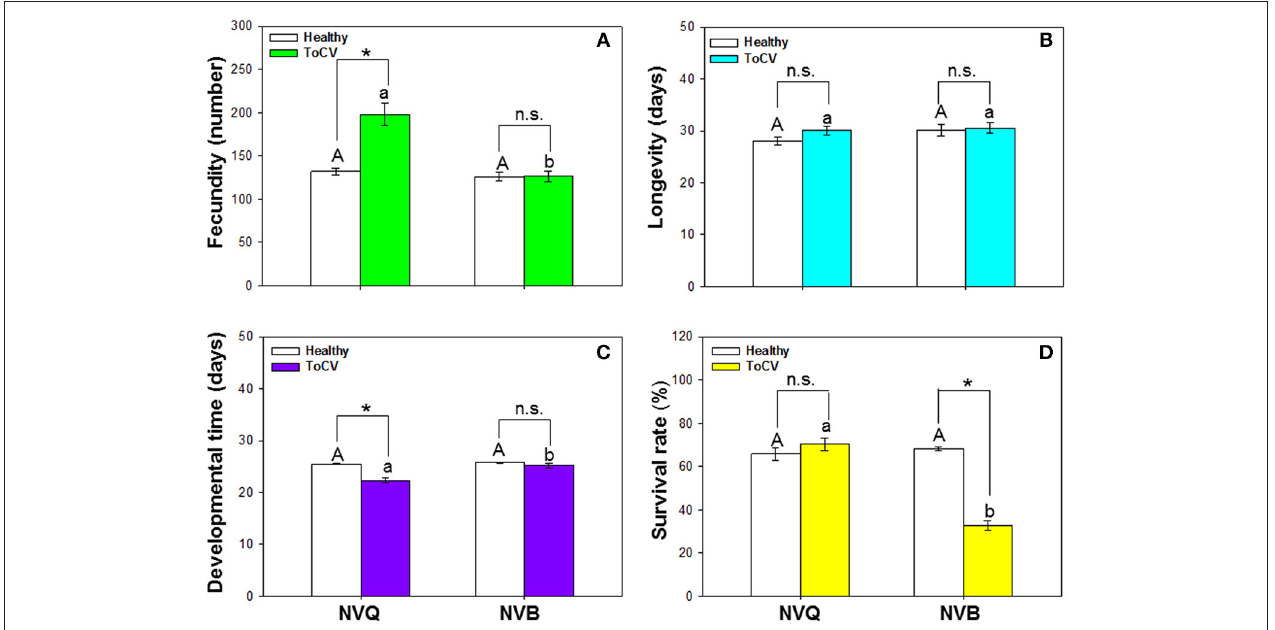
FIGURE 6 | Performance of non-viruliferous B. tabaci MEAM1 and MED on tomato chlorosis virus -infected vs. healthy tomato plants. (A) Fecundity. (B) Longevity. (C) Developmental time. (D) Survival rate. NVB, non-viruliferous MEAM1; NVQ, non-viruliferous MED. Values are means ± SE. In each panel, means with different uppercase letters are significantly different for NVB vs. NVQ on healthy plants; means with different lowercase letters are significantly different for NVB vs. NVQ on infected plants ( P < 0.05; N = 30); an asterisk indicates a significant difference for NVB (or NVQ) on healthy vs. infected plants; and n.s. indicates no significance for NVB (or NVQ) on healthy vs. infected plants ( P < 0.05 for all